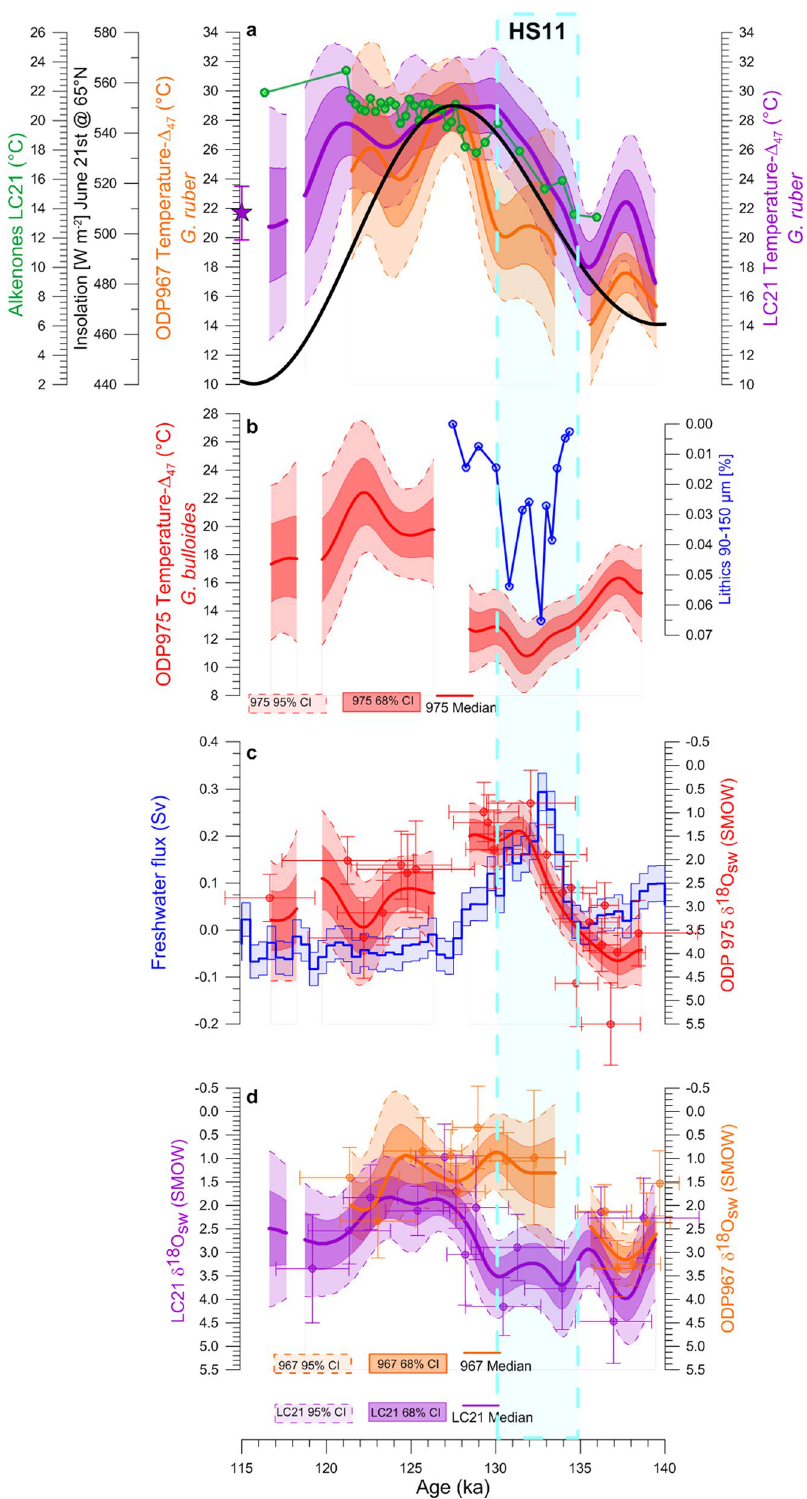
Figure 4. TII temperature and δ 18 O SW records across the Mediterranean Sea . ( a ) Northern Hemisphere insolation record at 65°N (black) overlain on the LC21 (purple) and ODP967 (orange) Δ 47 -temperature, K ′ and LC21 U 37 -temperature 32 (using ref. 6 age model) records from the eMed. ( b ) ODP975 G . bulloides Δ 47 - temperature record (red) and ice-rafted debris (Lithics 90–150 μm, %) concentrations from the Iberian Margin (blue 39 ). ( c ) Freshwater fluxes into the North Atlantic (blue 2 ) and ODP975 G . bulloides - δ 18 O SW (red). ( d ) G . ruber δ 18 O SW records from LC21 (purple) and ODP967 (orange). Dots, thick lines, and shadings as in Fig. 2c. LC21 Δ 47 late-Holocene temperature (purple star). Gaps in the final Δ 47 -records correspond to intervals where the age uncertainties of the Δ 47 -replicates do not overlap. Blue box highlights the